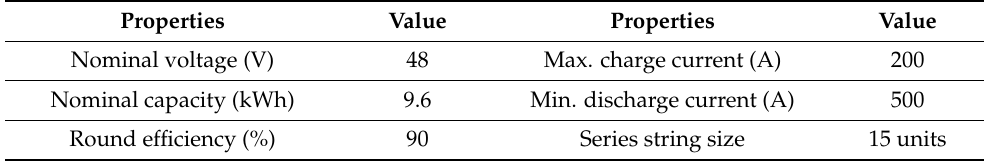
Table 3. Technical characteristics of BESS